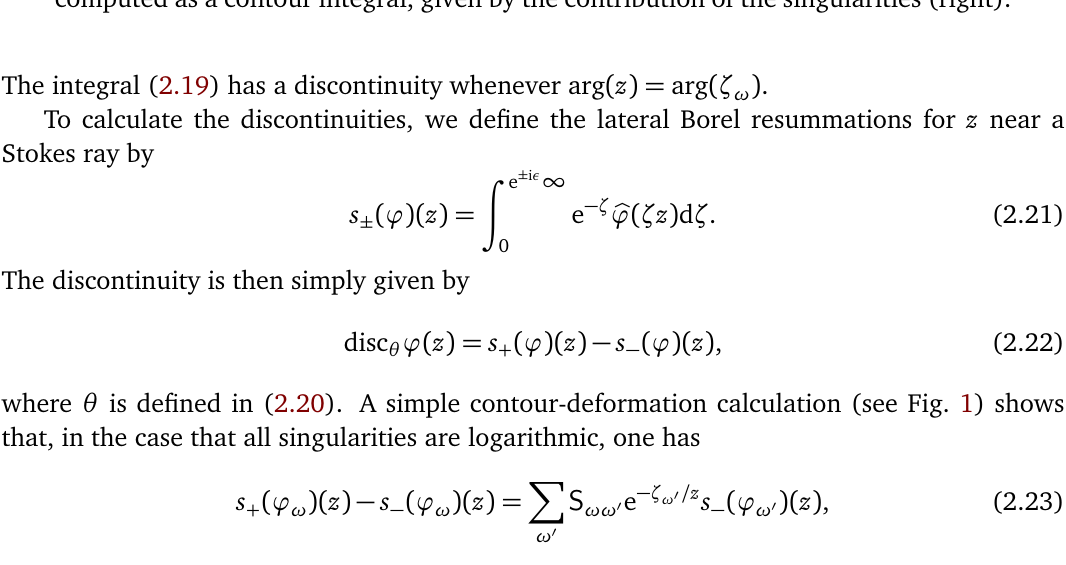
Figure 1: The difference between lateral Borel resummations in (2.23) (left) can be computed as a contour integral, given by the contribution of the singularities